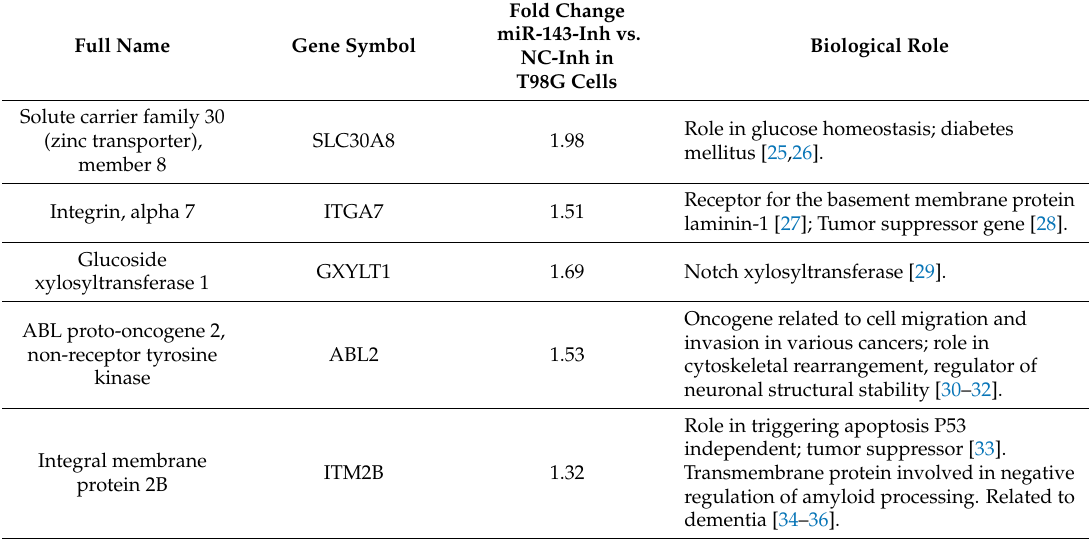
Table 1. List of the five miR-143 predicted target genes from qPCR results.